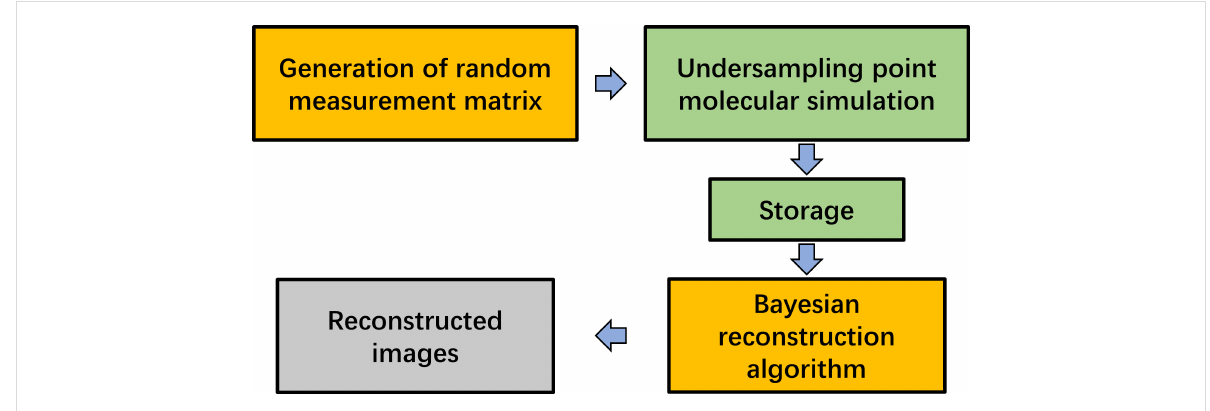
Figure 3: The block diagram of fast molecular simulation method for AFM imaging based on Bayesian compressed sensing. First, the random mea- surement matrix is obtained, then the pixel value is simulated according to random matrix positions, and finally the BCS method is used to recon- struct the complete image.